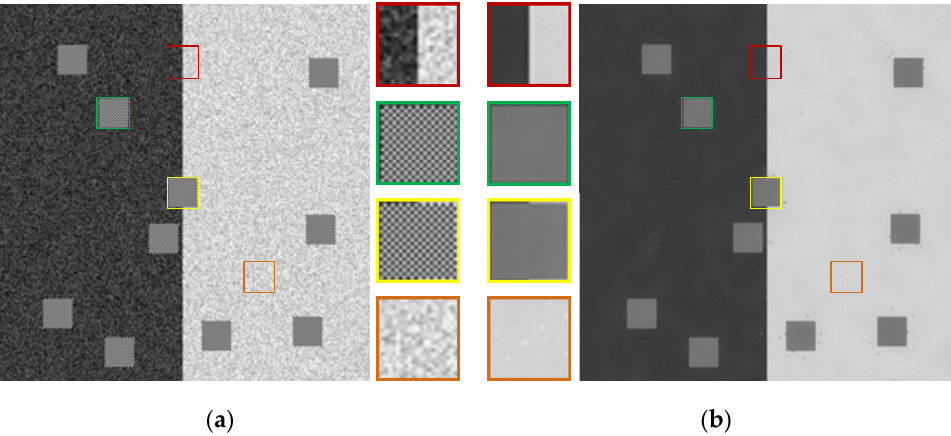
Figure 1. Working principle of Co-occurrence filter. ( a ) Image before COF processing, ( b ) Image after COF processing. COF